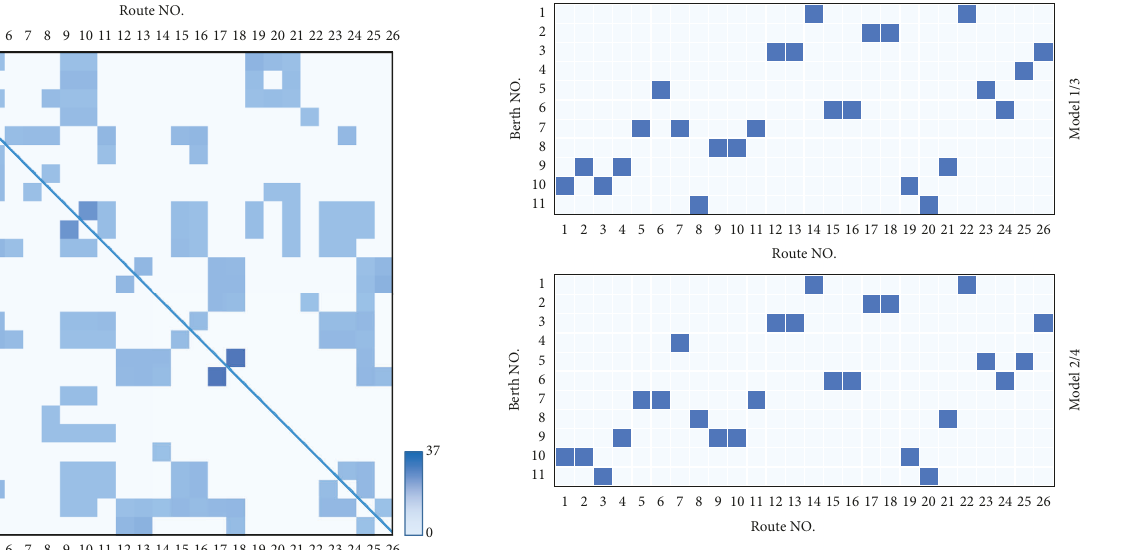
Figure 4: Schemes of route assignment to the hub berths from the proposed models. (a) Model 1/3 result. (b) Model 2/4